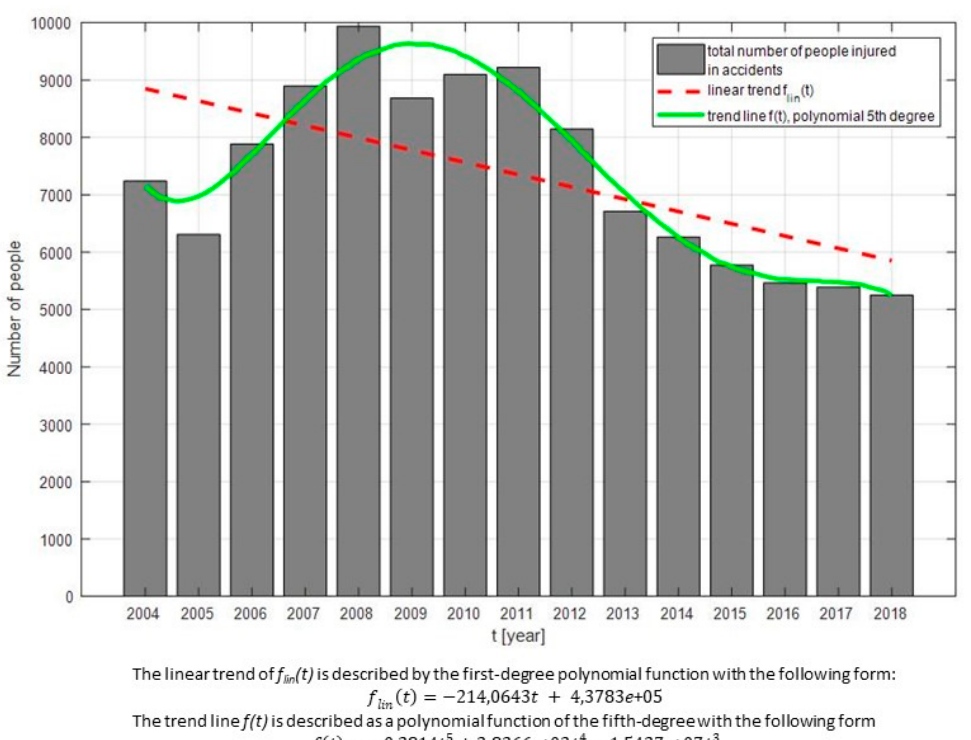
Figure 1. Trends in the total number of civil engineering workers injured by workplace accidents over time.